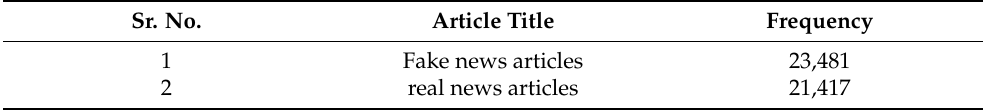
Table 1. The number of real and fake news. Sr.